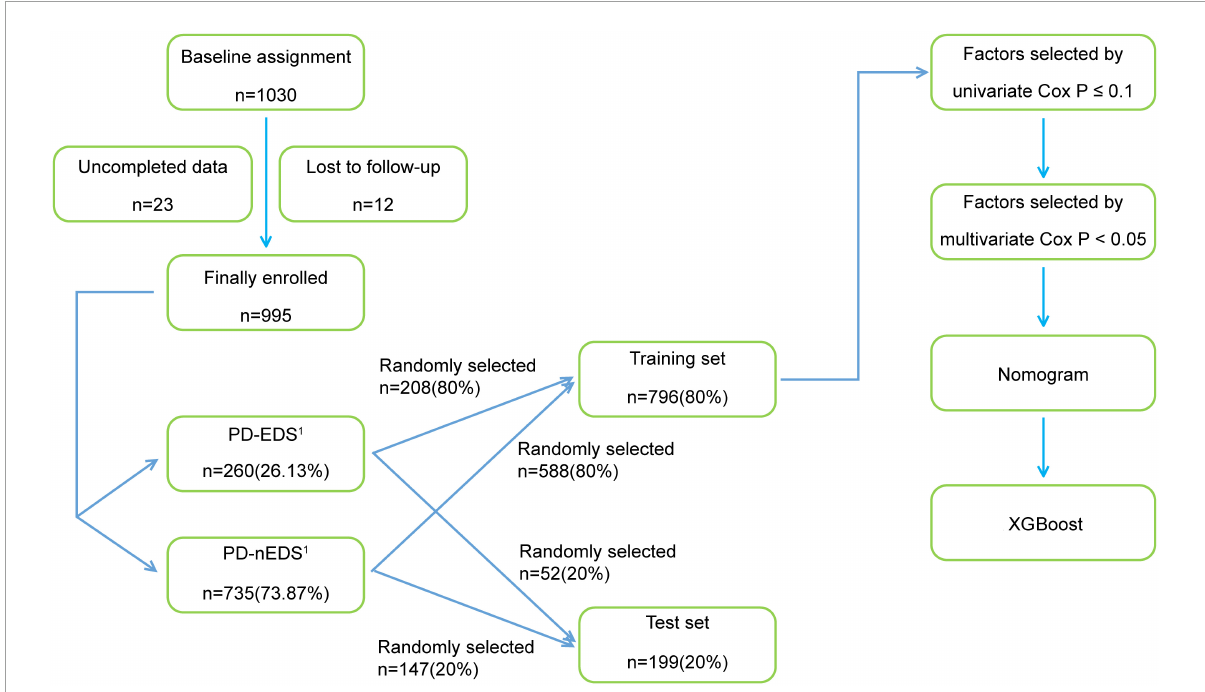
FIGURE1 The flow chart of the study. PD-EDS 1 , patients with PD with EDS after 1 year; PD-nEDS 1 , patients with PD without EDS after 1 year; PD, Parkinson’s disease; EDS, excessive daytime sleepiness; XGBoost, eXtreme Gradient